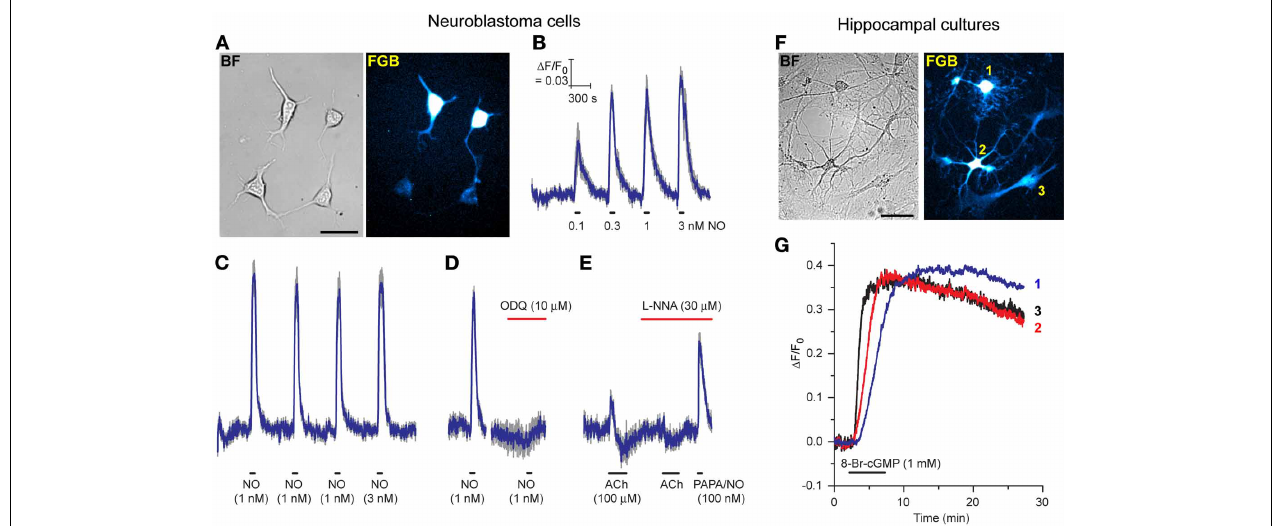
FIGURE 6 | Expression of FGB in differentiated N1E-115 neuroblastoma cells (A–E) and rat hippocampal cell cultures (F,G). (A) Brightfield (left) and fluorescent (right) images of neuroblastoma cells (two transfected, two untransfected); scale bar = 50 μ m. (B) Response to increasing clamped NO concentrations applied at the horizontal bars (5 cells). (C) Response to three consecutive 1nM NO applications followed by 3nM NO (10 cells). (D) Inhibition of the response to 1nM NO by ODQ (8 cells). (E) Response